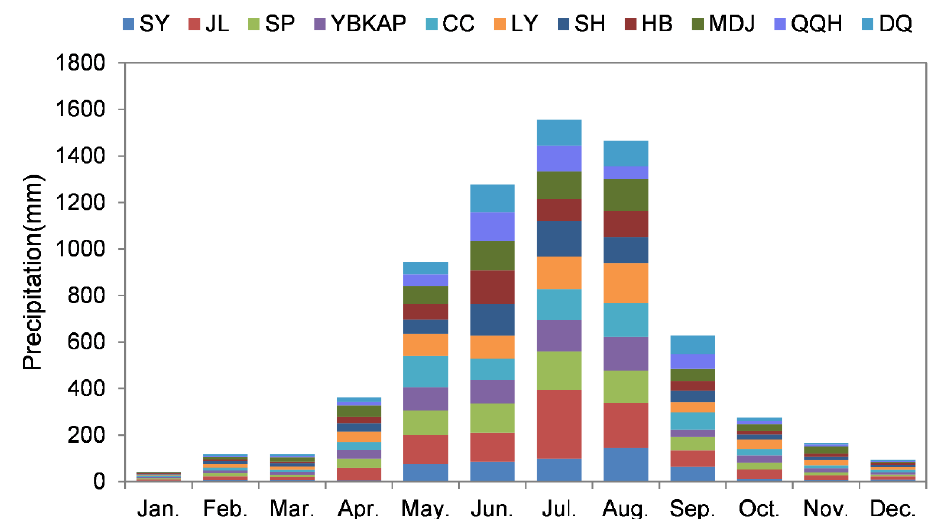
Figure 6. Monthly rainfall distribution in HCUA.